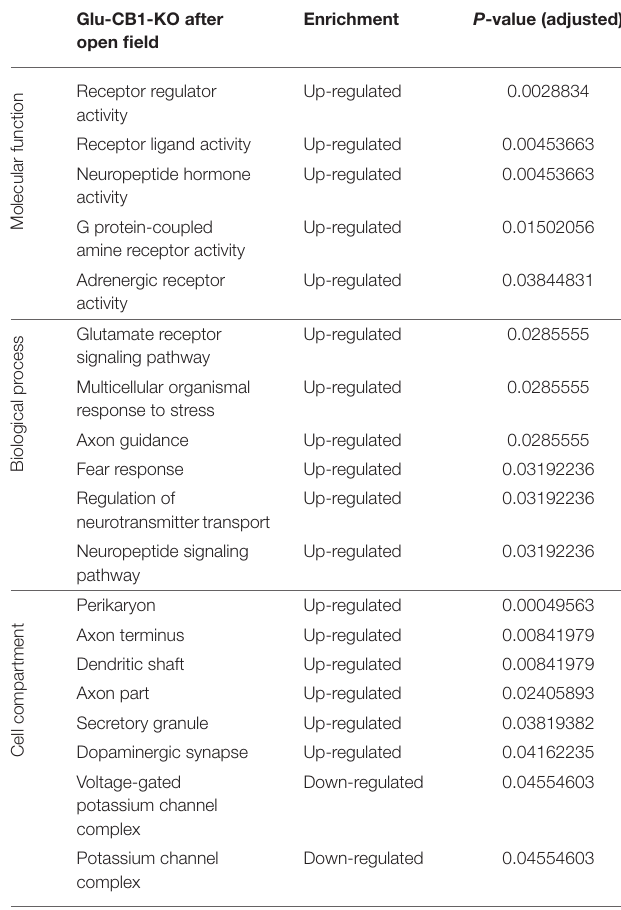
Table showing the list of GO terms resulting after analyzing the DEGs in the comparison Glu-CB1-KO vs. CB1-WT after open field exposure. GO terms marked as downregulated indicate that these terms are enriched for downregulated DEGs, and the opposite holds true for terms marked as